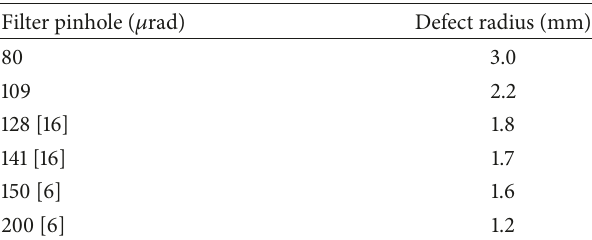
Table 1: Maximum allowable defect radiuses in different high- power laser systems.